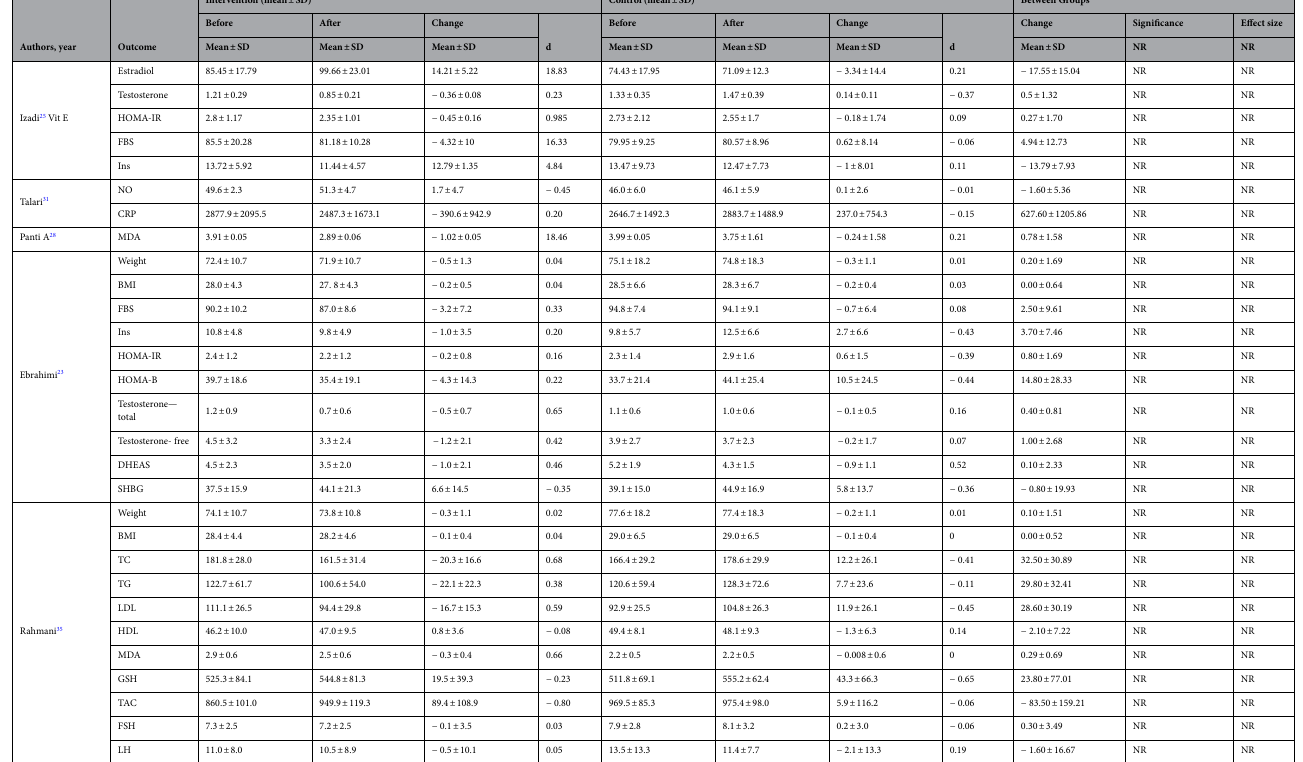
Table 2. The effect of vitamin E supplementation on cardiometabolic risk factors, inflammatory and oxidative markers, and hormonal functions in PCOS women. a In this study intervention group consists of groups B and C with Vitamin E treatment during follicular and luteal phase, respectively. SD standard deviation, d Coheoh’s d, LH luteinizing hormone, FSH follicular stimulating hormone, PRL prolactin, SHBG sex hormone